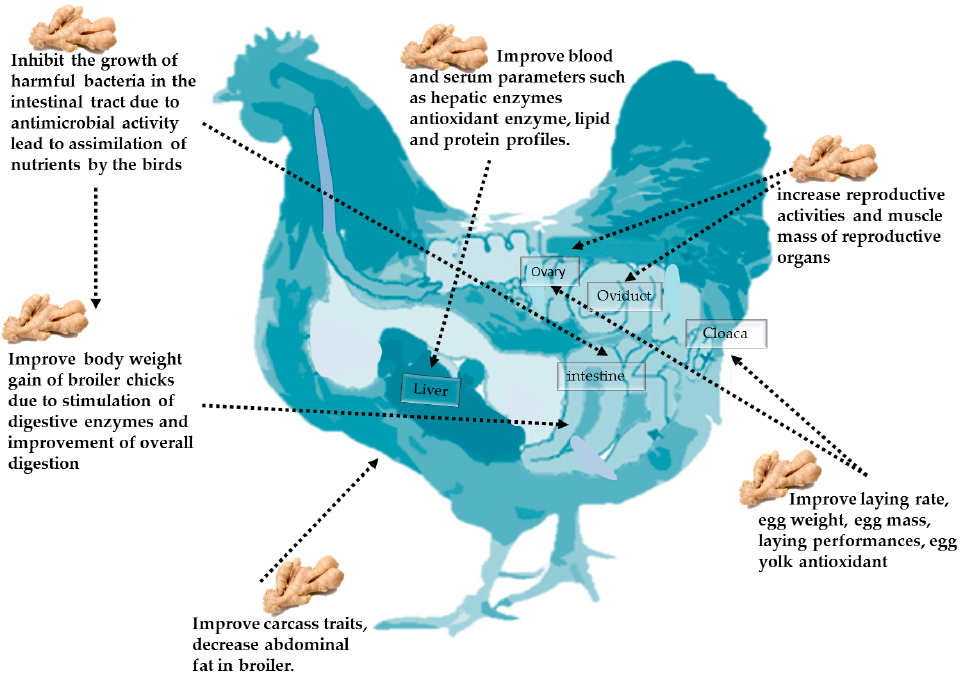
Figure 4. The beneficial application of ginger and its derivatives in poultry